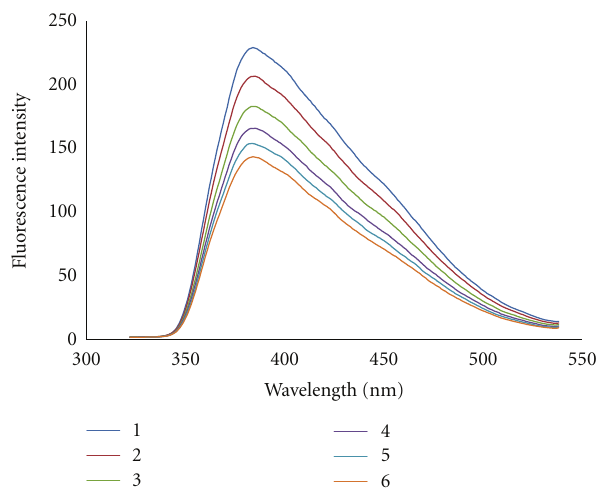
Figure 5: Fluorescence spectra of Pt(II) complex in the several concentrations of CT-DNA.